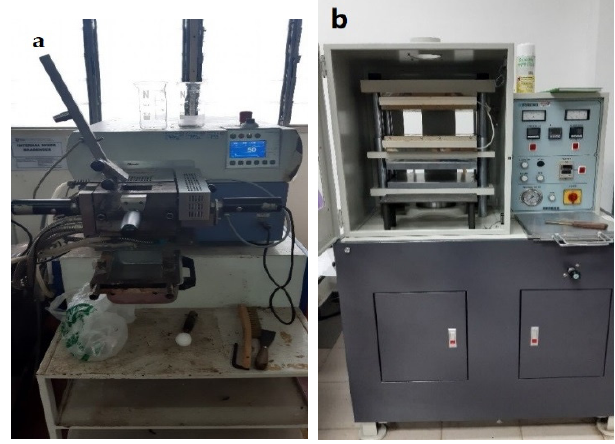
Figure 1. ( a ) Brabender Plastograph internal and ( b ) hot press machine.